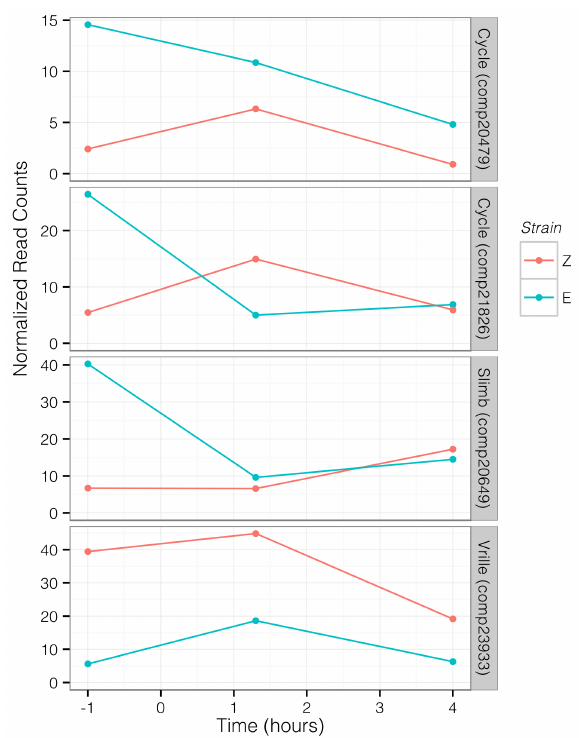
Figure 5. Trajectory of circadian transcript expression levels through time for transcripts that were significantly differentially expressed between strains. Each line represents a single component, with normalized counts at each time point averaged across libraries. Data collection time points were 1 h before scotophase, 1.3 h into scotophase, and 4 h into scotophase. Red indicates values for UZ, blue indicates